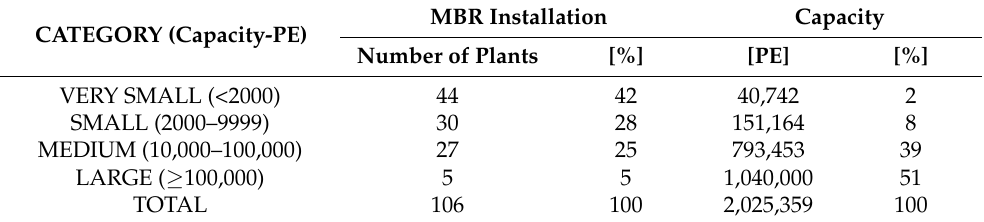
Table 1. Italian MBR plants treating municipal wastewater.